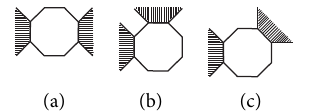
, (b) G , and (c) G 1 2